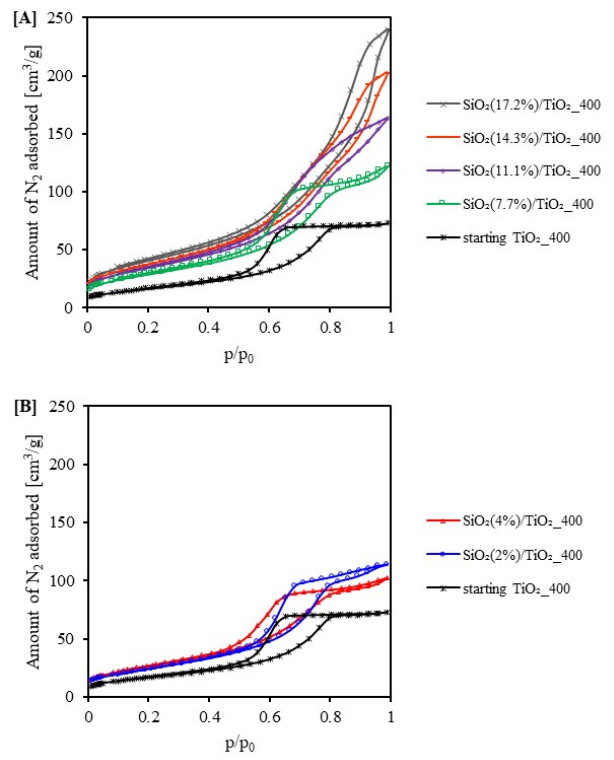
Adsorption–desorption isotherms of: ( A ) starting TiO 2 _400, SiO 2 (2%)/TiO 2 _400 and SiO 2 (4%)/TiO 2 _400, ( B ) starting TiO 2 _400, SiO 2 (7.7%)/TiO 2 _400, SiO 2 (11.1%)/TiO 2 _400, SiO 2 (14.3%)/TiO 2 _400 and SiO 2 (17.2%)/TiO 2